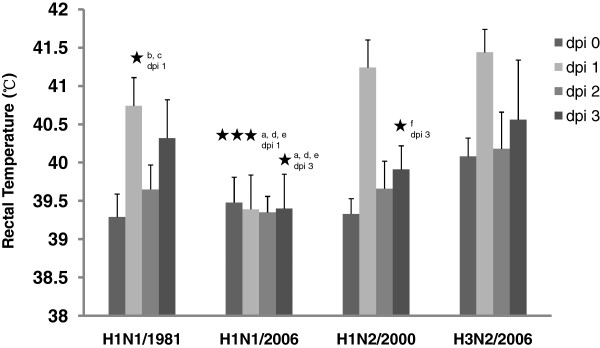
Rectal temperature. Rectal temperatures (°C) in pigs after experimental aerosol infection with swine influenza A viruses, dpi, days post infection; statistics: asterisk (1 p < 0.05, 2 p < 0.010, 3 p < 0.005, comparison of following groups: a H1N1/1981:H1N1/2006, b H1N1/1981:H1N2/2000, c H1N1/1981:H3N2/2006, d H1N1/2006:H1N2/2000, e H1N1/2006:H3N2/2006, f H1N2/2000:H3N2/2006).